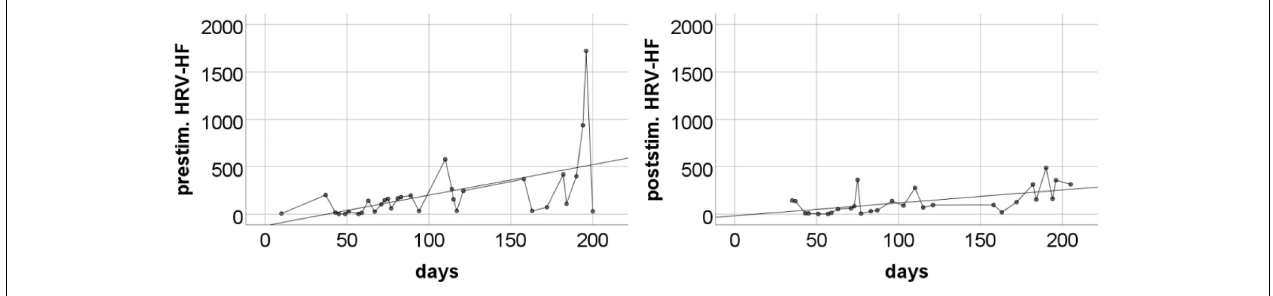
FIGURE 5 | The pre-stimulation (left panel) and post-stimulation (right panel) HRV-HF power levels from all measurements during the entire program period. Solid line is the best fitted regression line (mathematical description in Table 5 ).